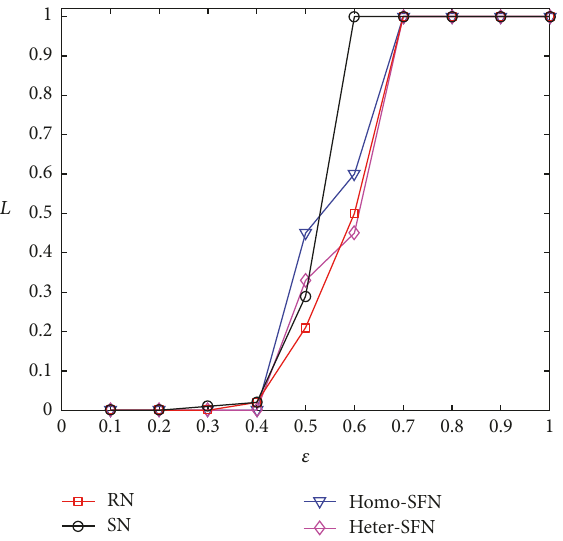
Figure 14: Failure size 𝐿 with varying types of matrix 𝐴 under random attack ( 𝑅 = 2 , 𝜀 = 0.6 ).